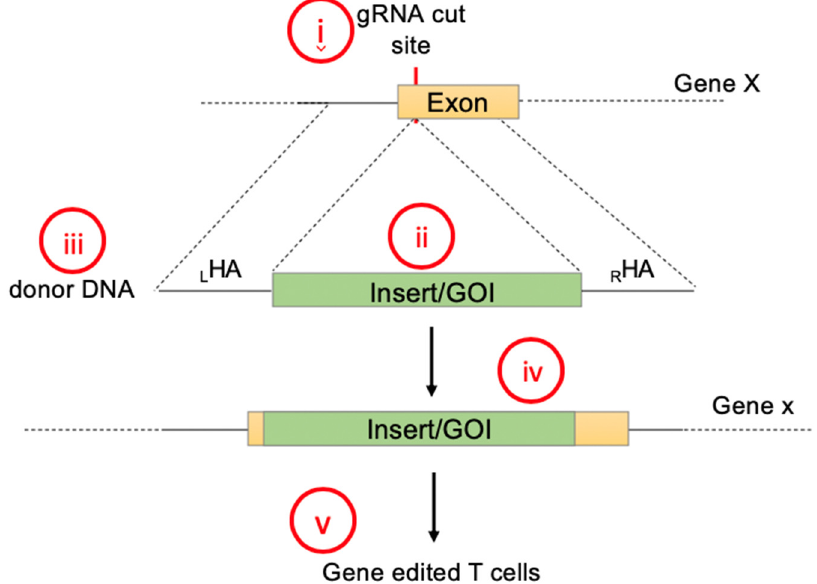
Figure 1. Steps to consider for transgene knock-in using non-viral DNA delivery: ( i ) Target site and guide RNAs, ( ii ) transgene design, ( iii ) donor DNA length, DNA type and delivery method, ( iv ) detection and efficiency of the knock-in, and ( v ) viability and performance of genetically engineered T cell containing the gene of interest.